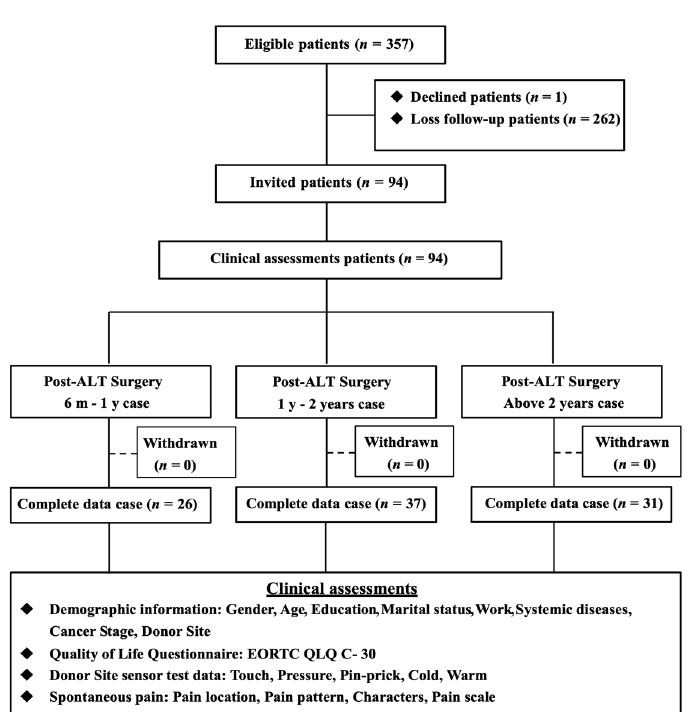
Figure 1. The study protocol. Abbreviations: ALT, anterolateral thigh.